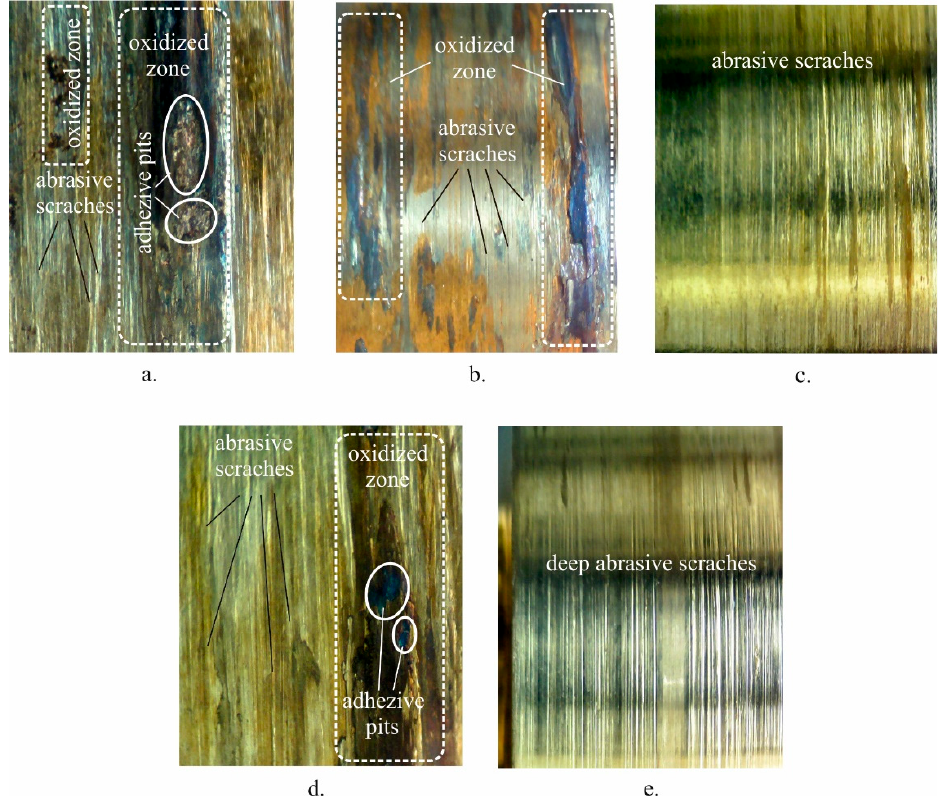
Figure 18. Worn surfaces under dry friction condition: ( a ) as received; ( b ) annealed; ( c ) quenched; ( d ) quenched and tempered at 600 ◦ C; ( e ) quenched and tempered at 300 ◦